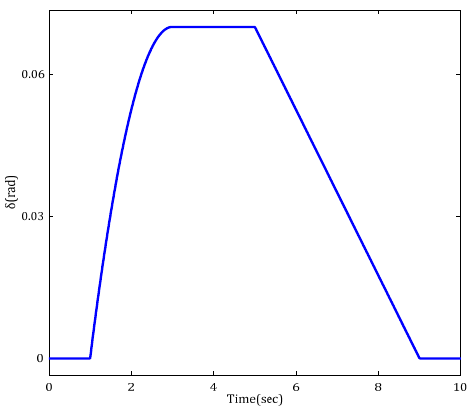
Figure 8. Front wheel steering angle under J-turn maneuver.